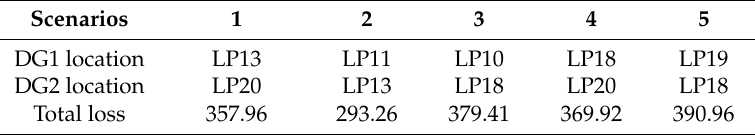
Figure 10. Allocated losses for five different location scenarios. Table 3. Total loss for five different DG location scenarios.